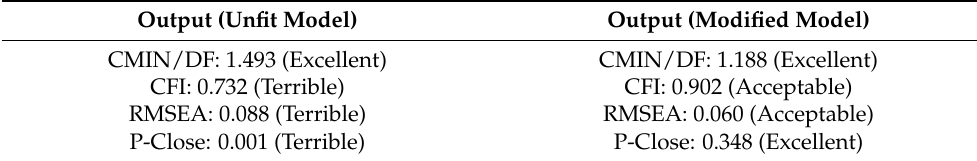
Table 7. Showing the model fit reference values [40,41].